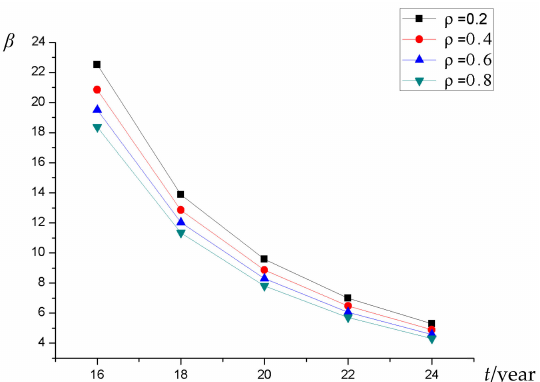
Figure 12. Non-probabilistic time-varying reliability indexes considering axial corrosion defects, growth rate, and radial corrosion defects growth rate.